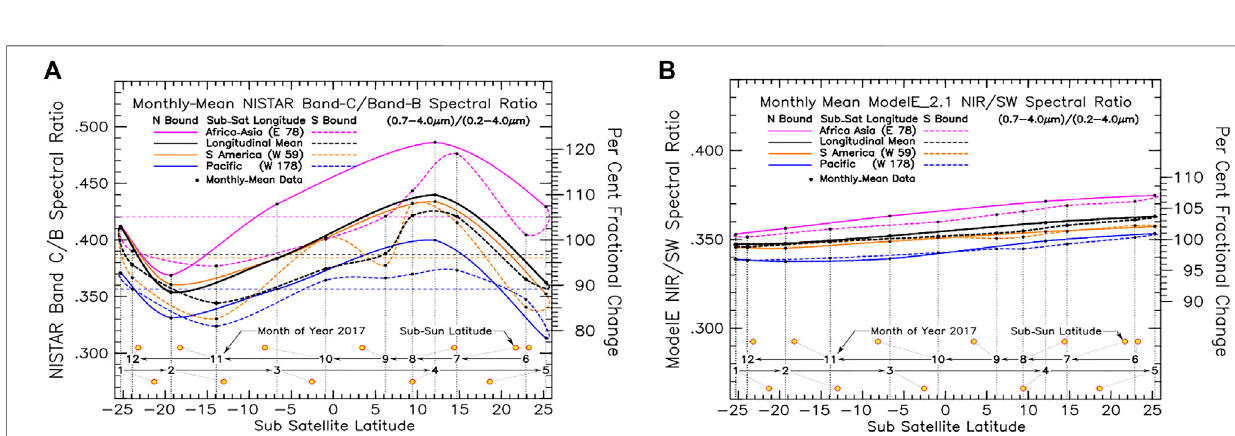
FIGURE5| SeasonalvariabilityoflongitudinallyslicedNISTARBand-C(0.7 – 4 μ m)/Band-B(0.2 – 4 μ m)NIR/SWspectralratioforyear2017 (A) ,andtheinverseVIS/ VIS + spectral ratio ofBands-(B-C) (0.2 – 0.7 μ m)/Band-D(0.3 – 1.1 μ m) (B) .The colored curves represent longitudinallysliced hemisphericviews ofgeographicalregions identi fi ed by their noon-time meridians. The heavy black lines represent full-day averages. The heavy yellow curves depict the seasonal variation of the Total Solar Irradiance (TSI) as referenced by the Y -axis scale at left.